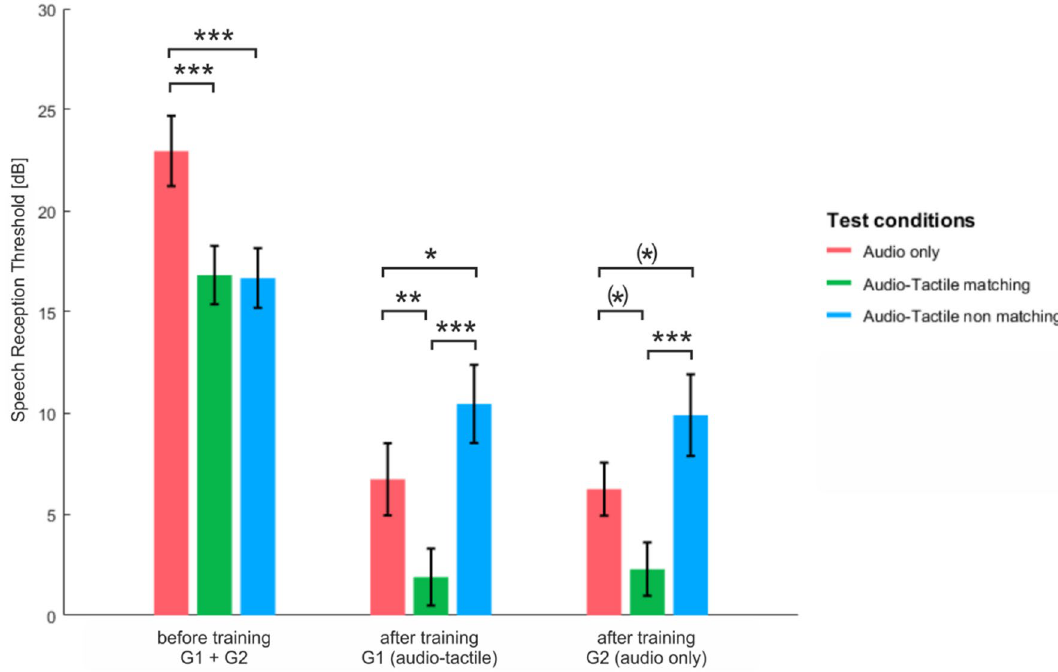
Figure 4. Speech reception thresholds in two sessions separately; bars correspond to standard errors of the mean; p values were Bonferroni corrected, *indicates p < 0.017, **indicates p < 0.003, ***indicates p <